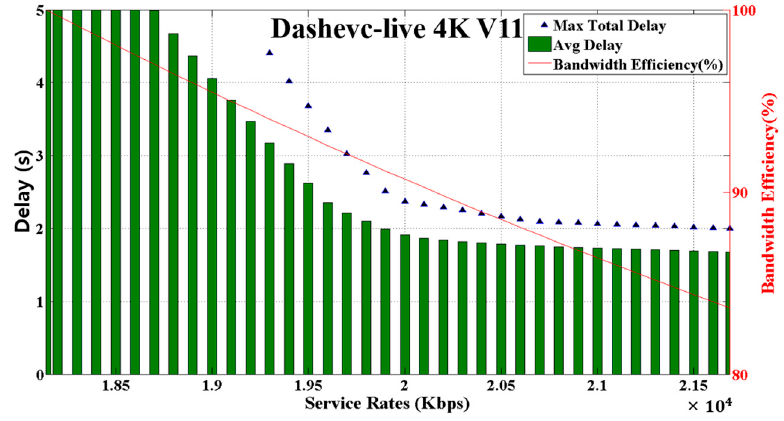
Figure 7. Simulation results of ‘Dashevc-live 4K V11’. Table 7. Simulation results of ‘Dashevc-live 4K V11. Bandwidth Efficiency and Delays per Service Bit Rate.